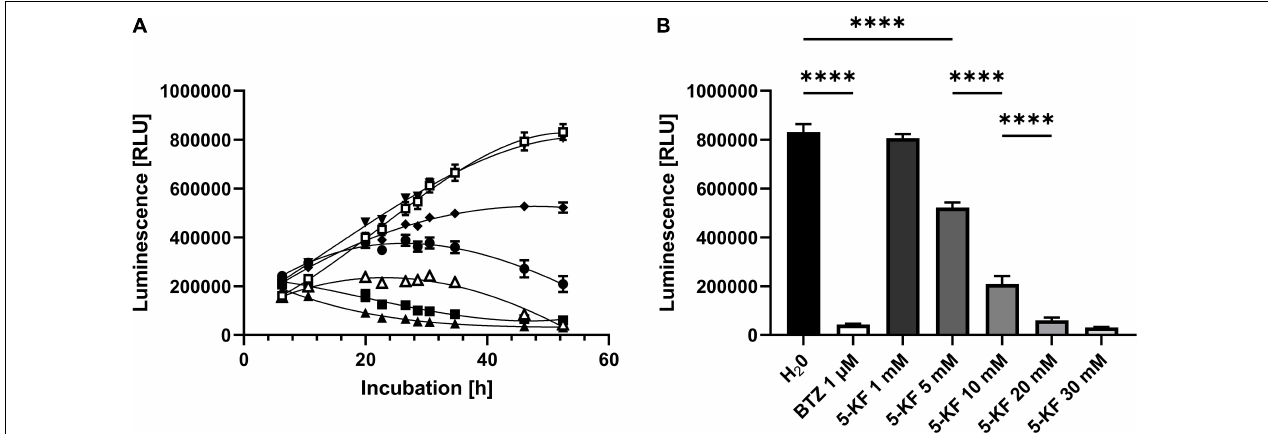
FIGURE 5 | Relative luminescence units (RLUs) produced by HT-29 cells during (A) and at the end (B) of Promega’s RealTime-Glo TM MT Cell Viability assay. HT-29 cells (1,500 cells per well) were incubated in DMEM High glucose medium supplemented with 10% fetal bovine serum (FBS) and antibiotic–antimycotic at 37 ◦ C in a humidified 5% CO 2 atmosphere. Cells were supplemented either with H 2 O pure ( (cid:3) ), bortezomib ( (cid:77) ), or varying concentrations of 5-KF ( (cid:72) 1 mM, (cid:7) 5 mM, (cid:4) 20 mM, (cid:78) 30 mM). Reagents of Promega’s RealTime-Glo TM MT cell viability assay were added according to the manufacturer’s instructions. At 10 individual time points, the relative luminescence units (RLUs) were assessed using a Promega Glomax R (cid:13) Discover System. Tukey’s multiple comparison test was performed using GraphPad 9.3.1 (GraphPad Software, San Diego, US) to determine statistical significance; ∗∗∗∗ p < 0.0001. The experiment was performed using six biological replicates for each test compound.